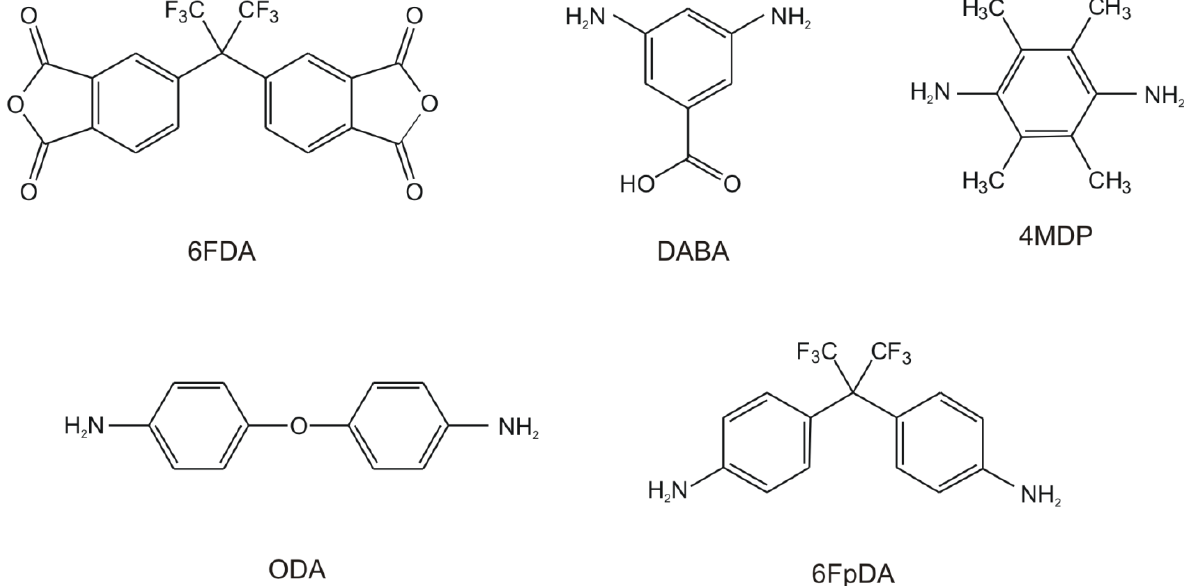
Figure 8. Chemical structures of the copolyimid components discussed in this